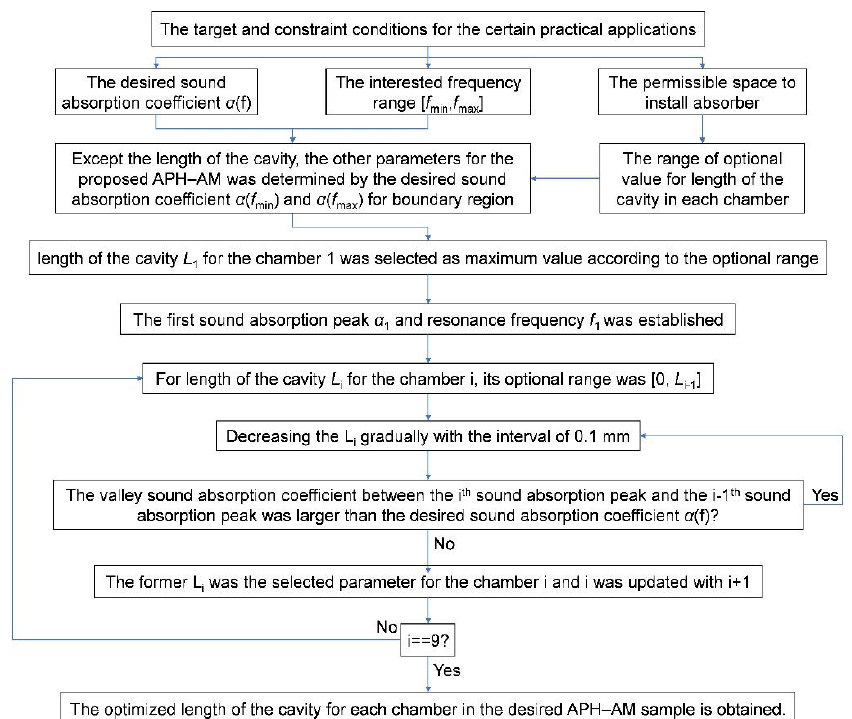
Figure 8. The optimization process in an achievement of the desired sound absorption performance for the APH-AM sample.